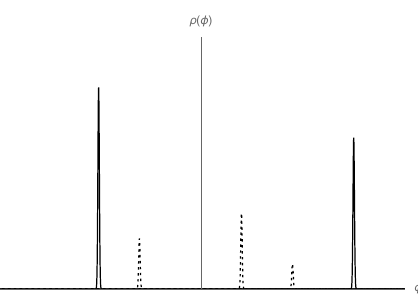
Figure 4 . Eigenvalue density at large N , in a phase in which three out of the F mass parameters fall inside supp ρ . The solid lines are the eigenvalues at the endpoints, the dashed lines are the (cid:3) for a better eigenvalues at − m . The range of the vertical axis is (cid:2) 0 , 1 α 2